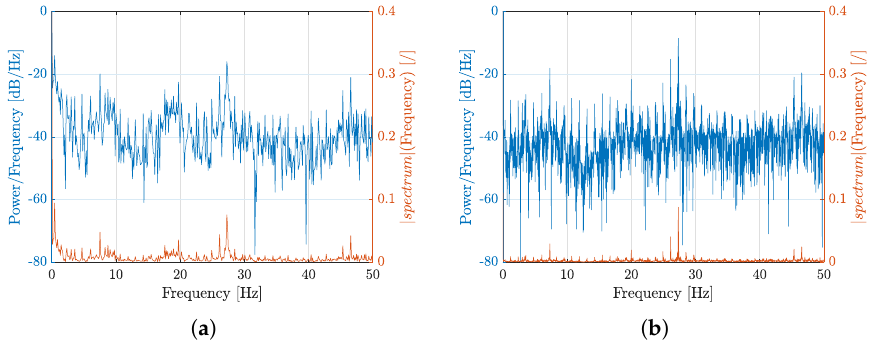
Figure 9. Frequency analysis of the numerical airspeed time derivative using the backward three-point scheme. ( a ) Positive TAS rate, ˙ V ∞ = 0.50ms − 2 , ( b ) Negative TAS rate, ˙ V ∞ = − 0.51ms − 2 .